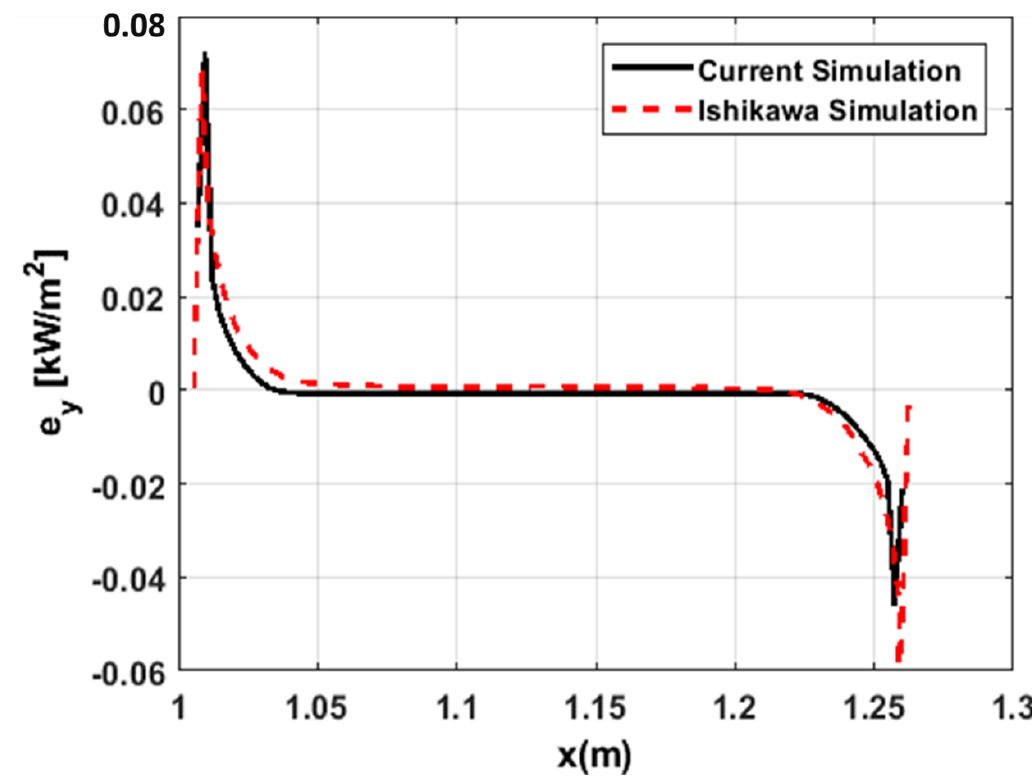
Figure 3. Comparison of time averaged energy flux density along the stack surface for validation purpose.